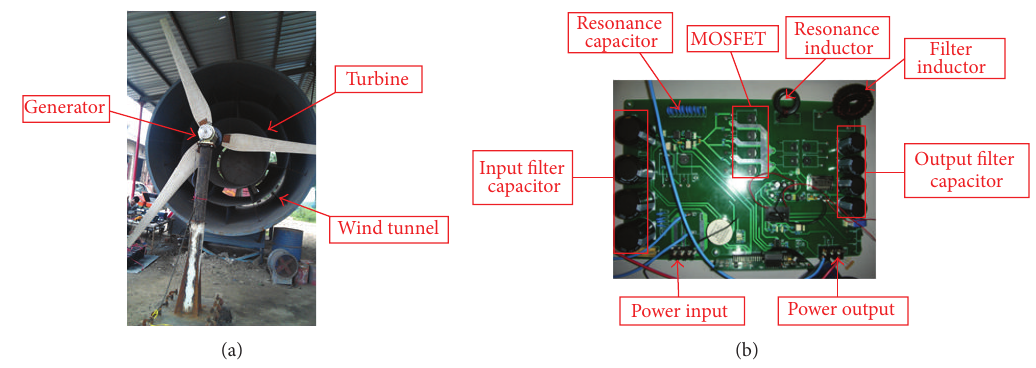
Figure 10: The actual wind generation system for experiment.